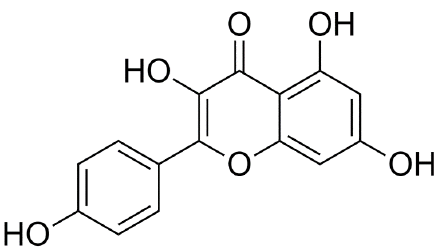
Figure 1. The two-dimensional structural formula of kaempferol.